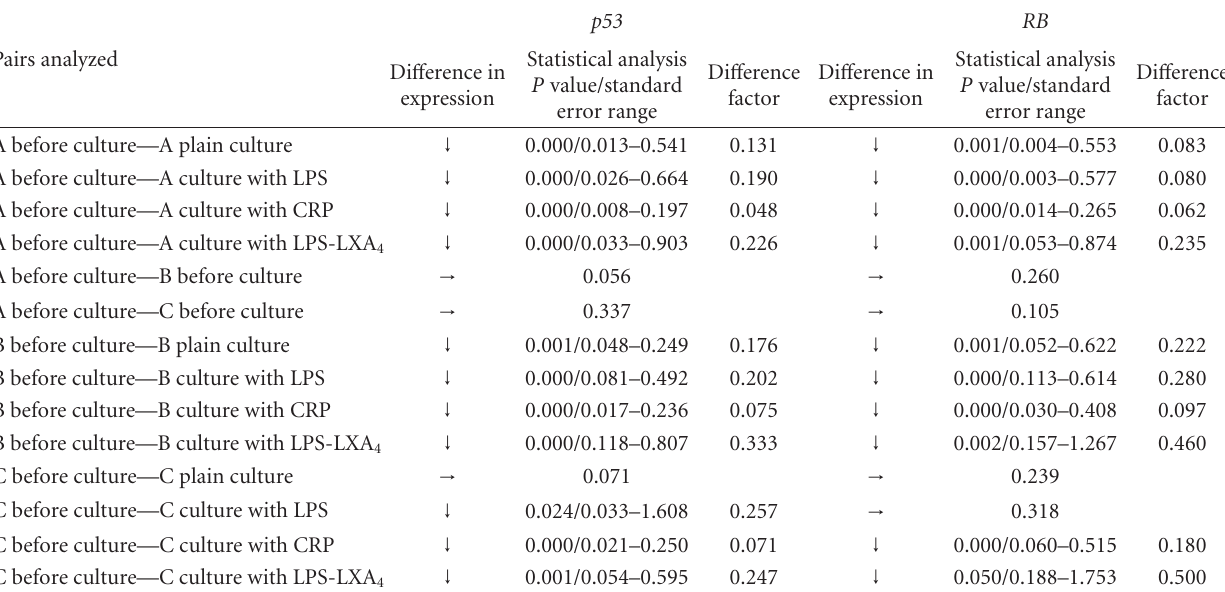
Table 2: Expression of p53 and RB in cultured and noncultured